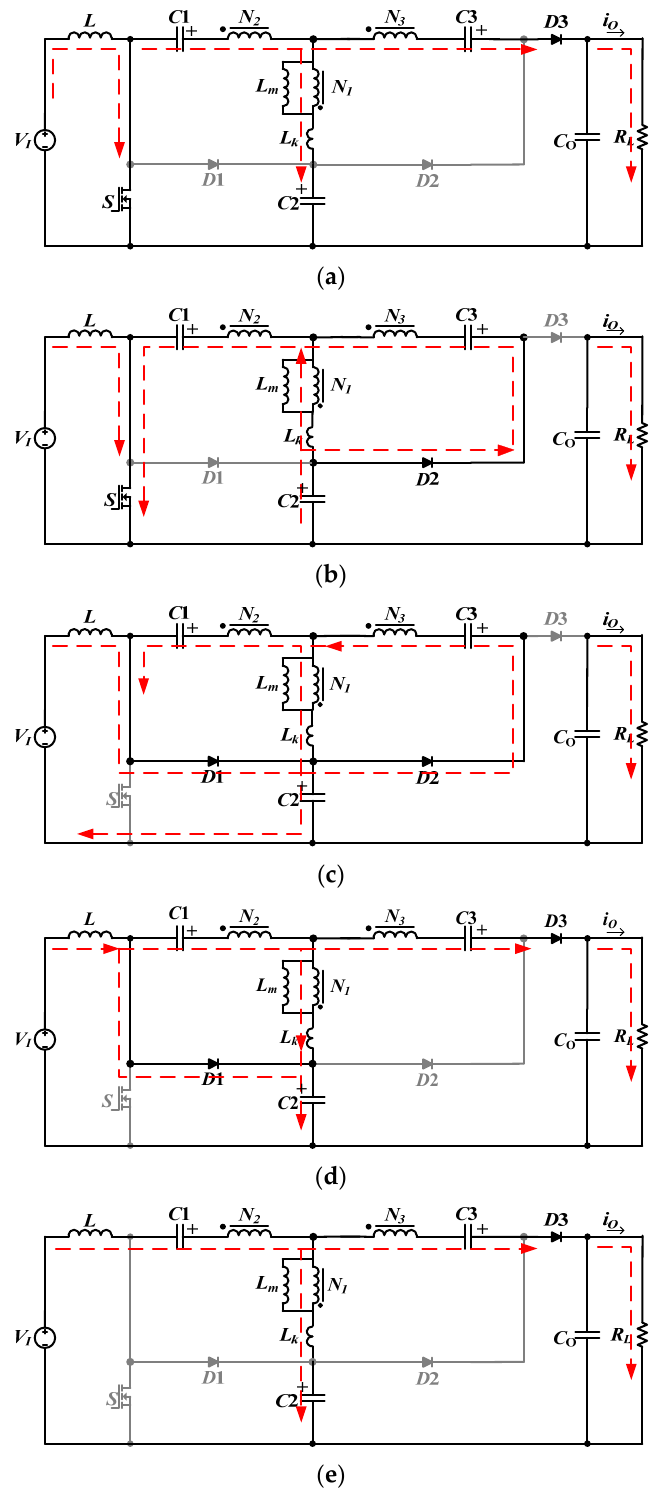
Figure 2. Different time intervals of the presented structure. ( a ) Operation mode I, ( b ) Operation mode II, ( c ) Operation mode III, ( d ) Operation mode VI, ( e ) Operation mode V. Mode I (Figure 2a): In the first operation mode, the power switch S is turned ON. The inductor L is charged by the input voltage. The diodes D 1 and D 2 are reversed biased, but the diode D 3 is turned ON to conduct the current of the third winding of the coupled inductor. The output capacitor